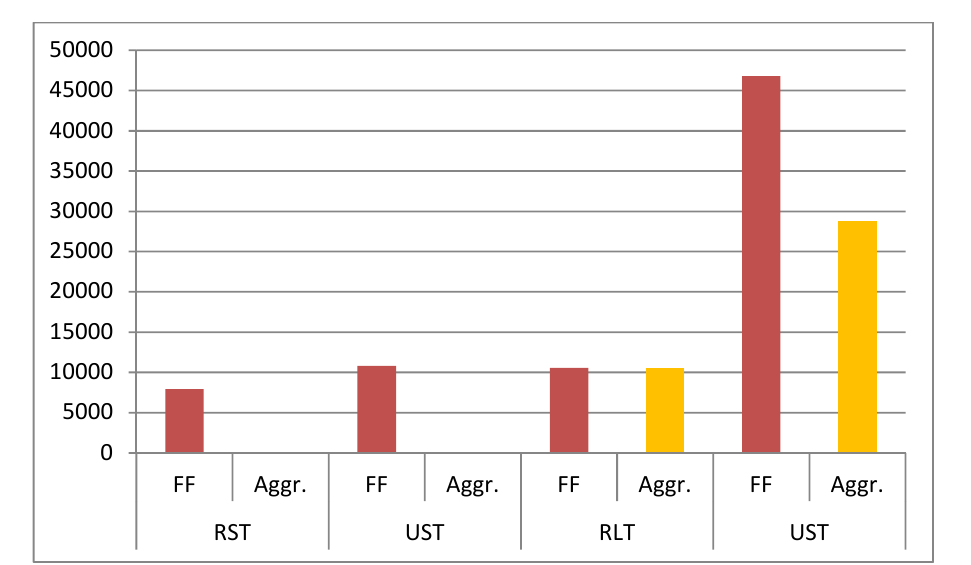
Figure 13. Annual savings of using TLS/SSL compared to using IPSec (C per district in each scenario depending on whether Fast Forwarding or Aggregation is